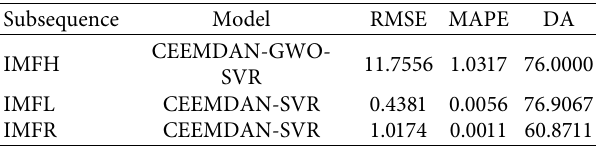
Table 5: Forecasting accuracy indexes of the three subsequences and the original gold price data.